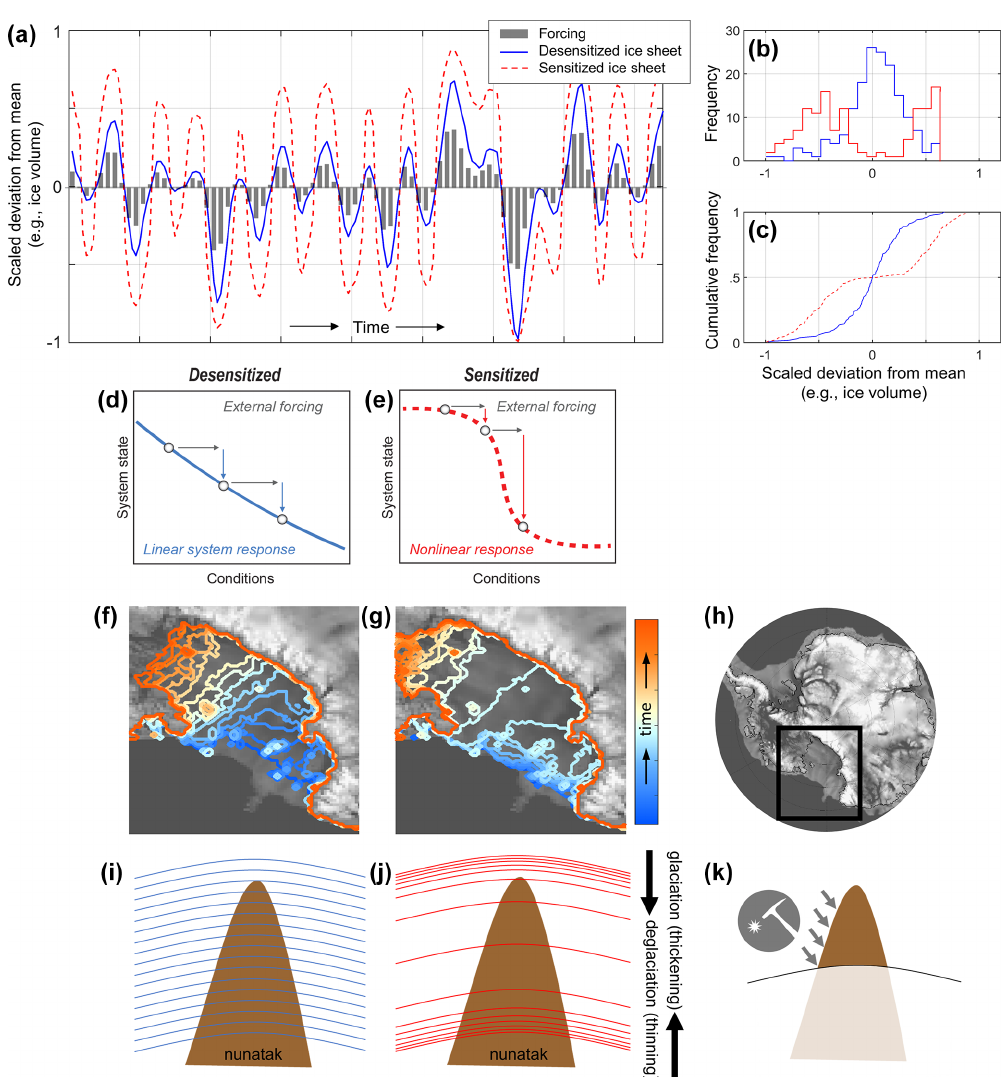
Figure 2. Conceptual illustration of sensitized versus desensitized ice sheet behaviour. (a) For a given forcing (grey bars), a desensitized ice sheet responds linearly (blue line) while a sensitized ice sheet responds non-linearly (dashed red). The y axis is shown as scaled deviation from the mean, so that ice volumes are normalized between − 1 and 1 in this hypothetical illustration. In this example, the hypothetical dataset is non-linearized using a simple exponential transformation. (b) Frequency and (c) cumulative frequency distributions of ice volumes for the sensitized and desensitized models illustrated in panel (a) . (d, e) Conceptual schematics of linear vs. non-linear responses to a given forcing (modified from Scheffer et al., 2009), leading to the differential ice sheet behaviour illustrated in panels (f) and (g) . (f, g) Characteristic grounding-line behaviour in the Ross Sea, Antarctica; location shown as a black box in panel (h) . Desensitized ice sheet behaviour is characterized by steady grounding-line recession throughout a deglaciation (f) , while a sensitized ice sheet is more susceptible to runaway positive feedback mechanisms that cause the grounding line to rapidly jump from maximum to minimum states (g) . (h) Continental bed topography (Fretwell et al., 2013) with a modern grounding line shown for context. (i, j) Characteristic ice thinning patterns for desensitized (i) and sensitized (j) ice sheet behaviour; coloured lines denote hypothetical ice surfaces as the ice sheet deflates and regrows over a nunatak, where cosmogenic-nuclide data could be sampled along the modern exposed surface (k)